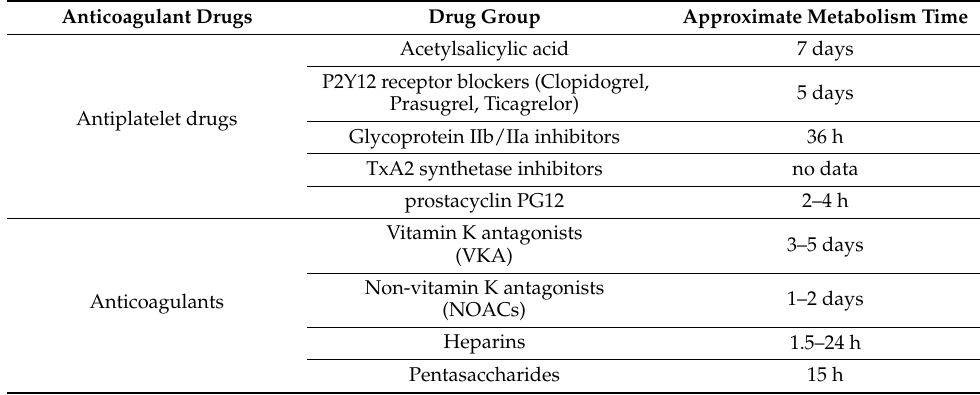
Table 1. Antithrombotic drugs types. Anticoagulant Drugs Drug Group Approximate Metabolism Time Antiplatelet drugs